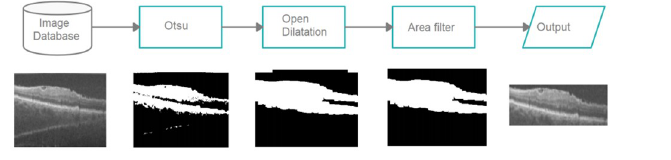
Fig 3. The process for defining the area of